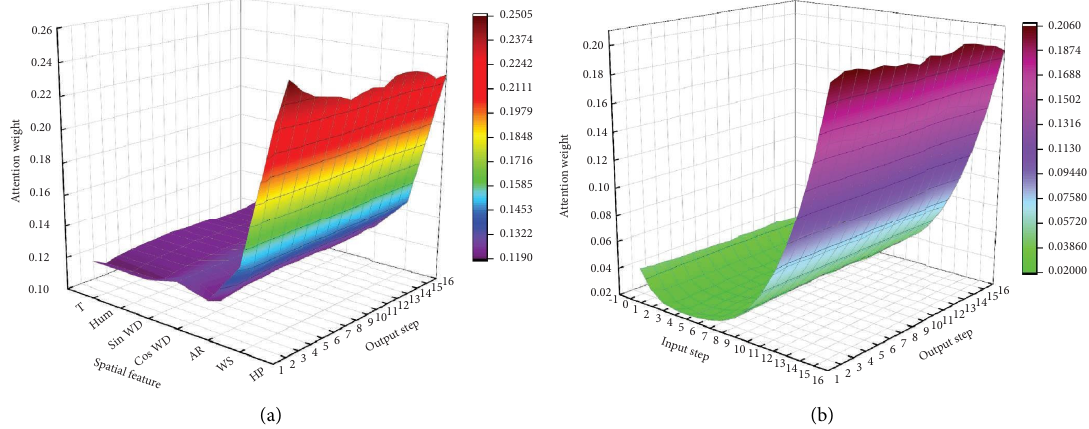
Figure 5: Attention weight distribution: (a) spatial attention weight distribution and (b) temporal attention weight distribution.